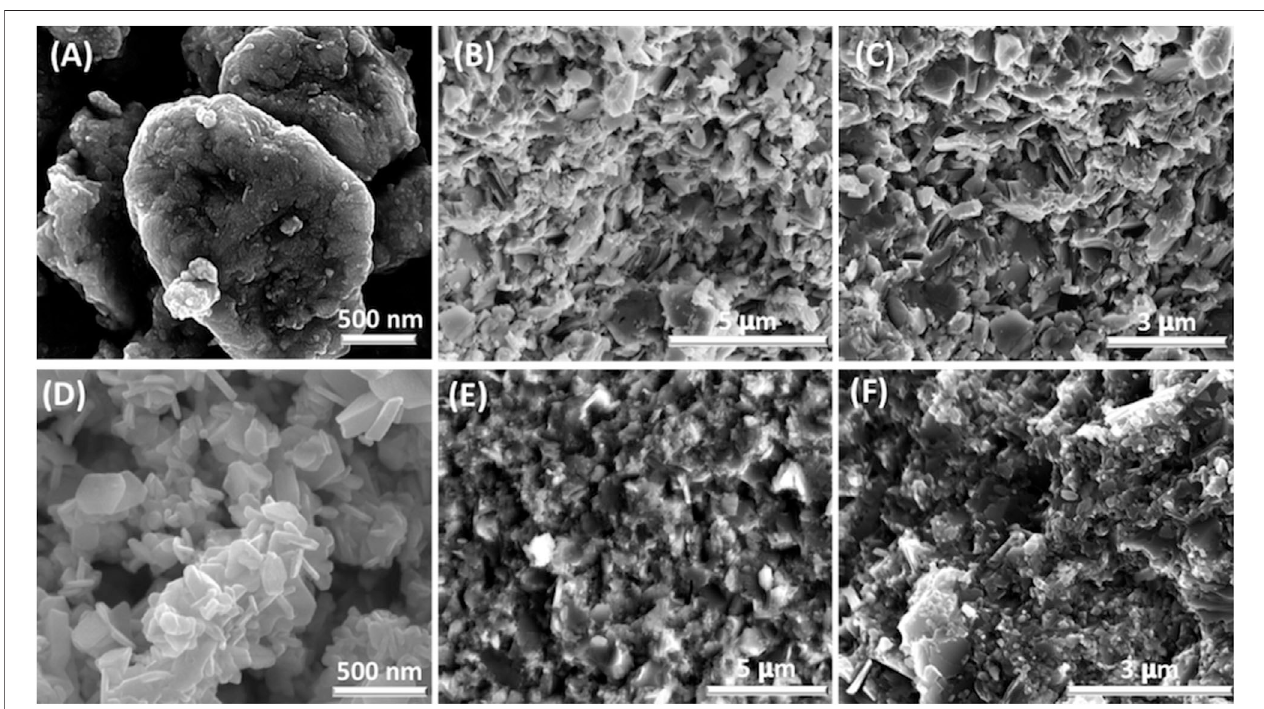
FIGURE 3 | FE-scanning electron microscopy micrographs of (A) as-milled MA-Bi 0.5 Sb 1.5 Te 3 , (D) as-made MW-Bi 0.5 Sb 1.5 Te 3 , and SPS sintered fractured (B,C)